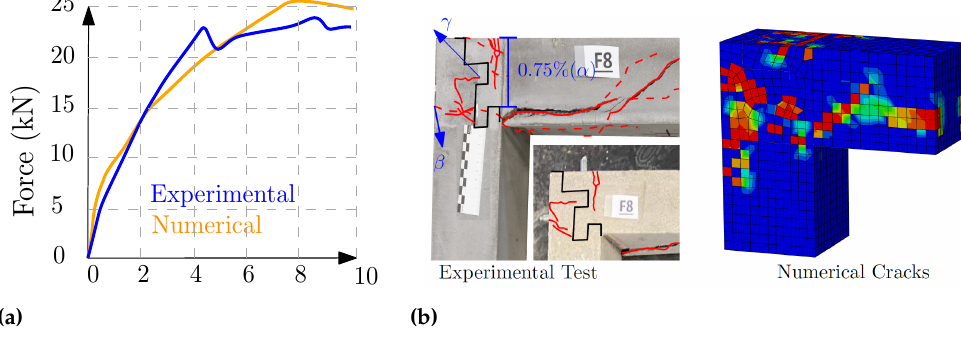
Figure 18. F7, ( a ) Force–deformation, ( b ) experimental cracking and numerical cracking